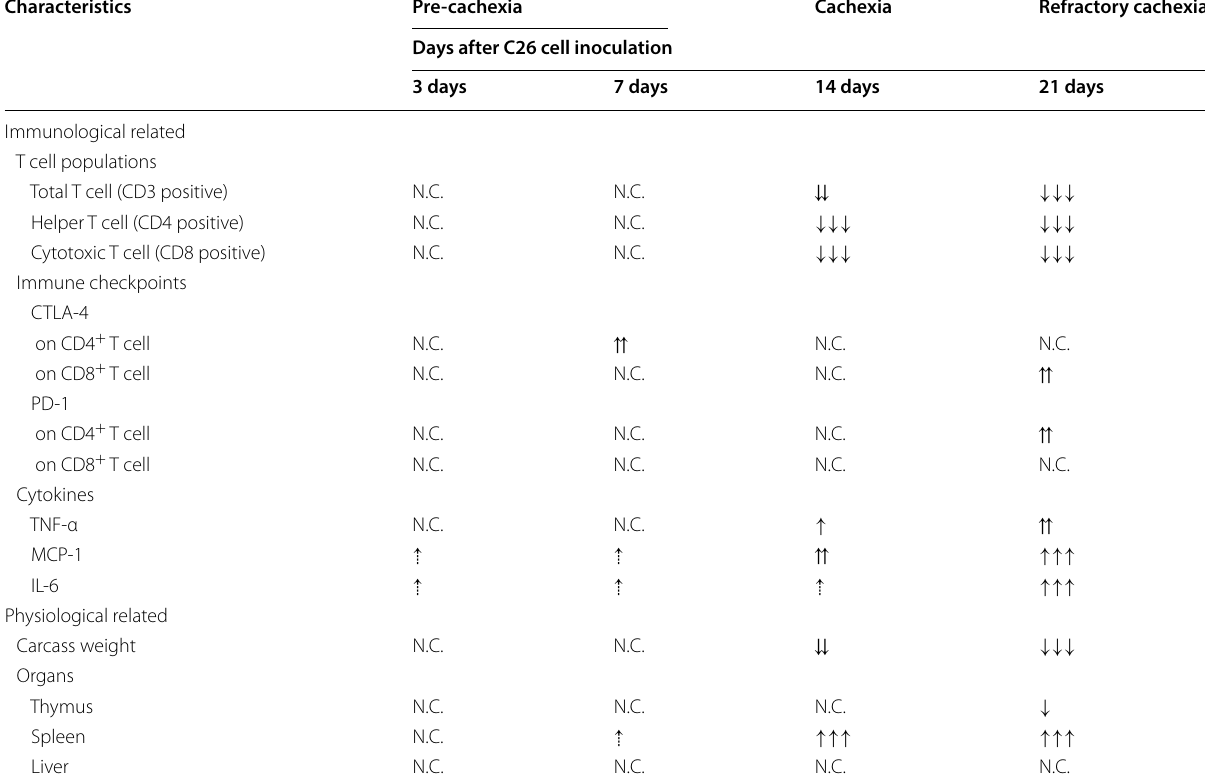
N.C.: no change, arrow with dotted line: high tendency compared with normal group, arrow with solid line: significance compared with 3 days after C26 cell inoculation, 1 of arrow with solid line: P < 0.05, 2 of arrow with solid line: P < 0.01, 3 of: arrow with solid line: P < 0.001